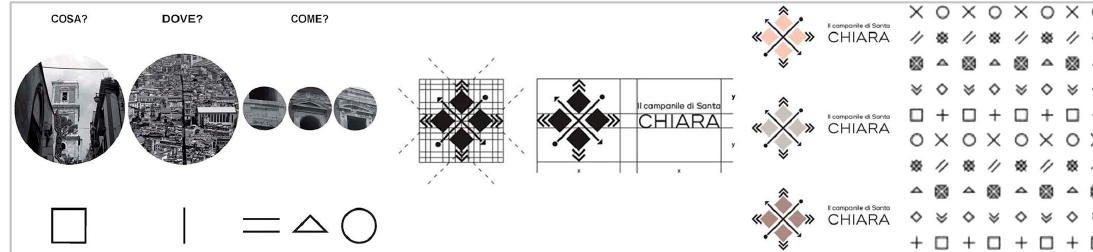
Figure 10. Santa Chiara bell tower, visual identity system (graphic design by Valentina